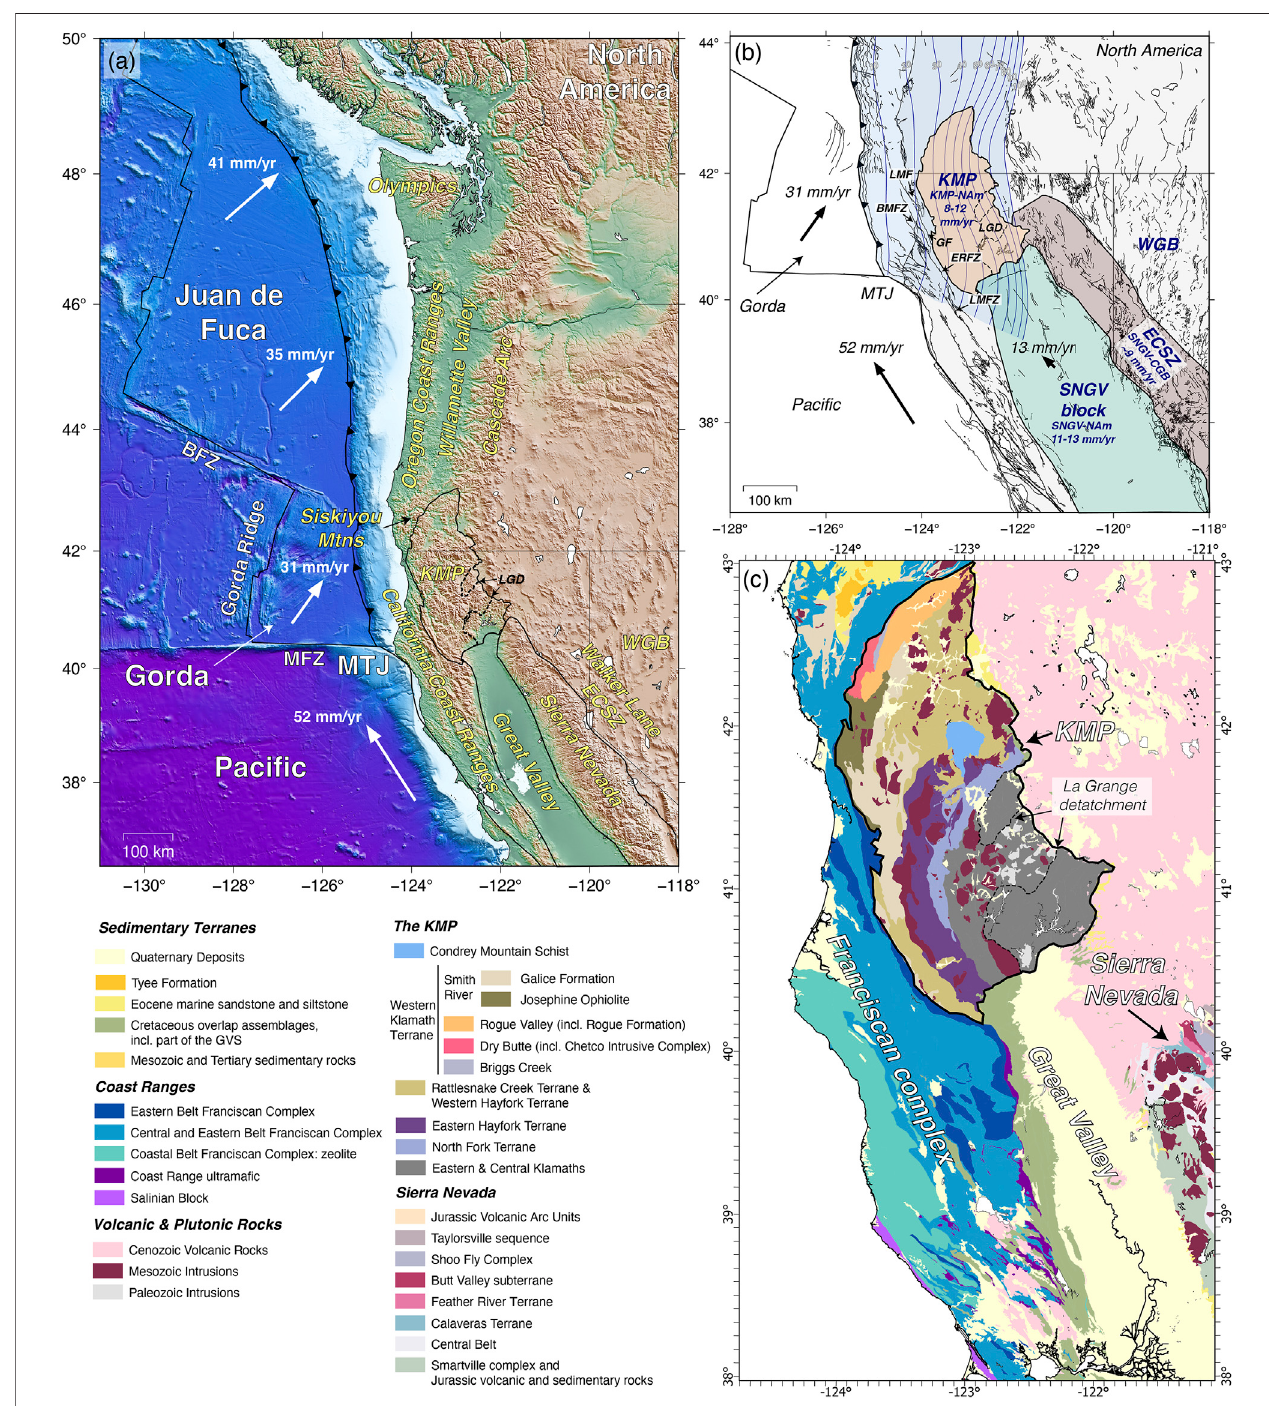
FIGURE 1 | Tectonic and geological setting of the study region and surrounding area. (A) Topographic map of northwest North America (SW British Columbia, Washington,Oregon,northernCalifornia,andNWNevada).Thenamesofkeygeographicandgeologicfeaturesandprovincesarelabeled(inyellowonlandandinwhite offshore). BFZ = Blanco Fracture Zone, MFZ = Mendocino Fracture Zone, MTJ = Mendocino Triple Junction, WGB = Western Great Basin, KMP = Klamath Mountain province, LGD = La Grange detachment, LMF = Lost Man fault, BMFZ = Bald Mountain fault zone, GF = Grogan fault, ERFZ = Eaton Roughs fault zone, LMFZ = Lake Mountain fault zone. (B) Kinematic setting of the study region showing present-day motions of the Juan de Fuca plate, Paci fi c plate and SNGV crustal block with respecttoNorthAmerica(DeMetsetal.,2010;d ’ Alessioetal.,2005).TheblueshadedregionistheextentofthesubductingslabatdepthfromSlab2(Hayes,2018),and thedarkblue linesarethe10 kmslabcontours. TheKMP,theSNGVblock, and theECSZareoutlinedandshaded inorange, greenand redrespectively. (C) Geological map of the study region.